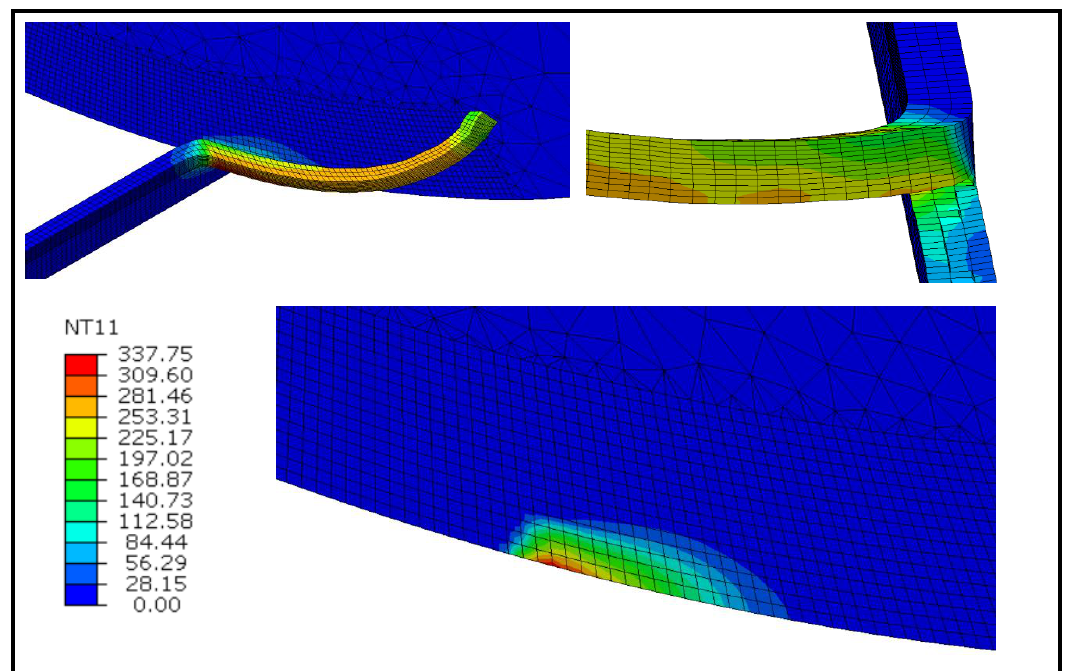
Figure 6. Temperature contours at V = 100 m/min for the rotating tool case (°C).